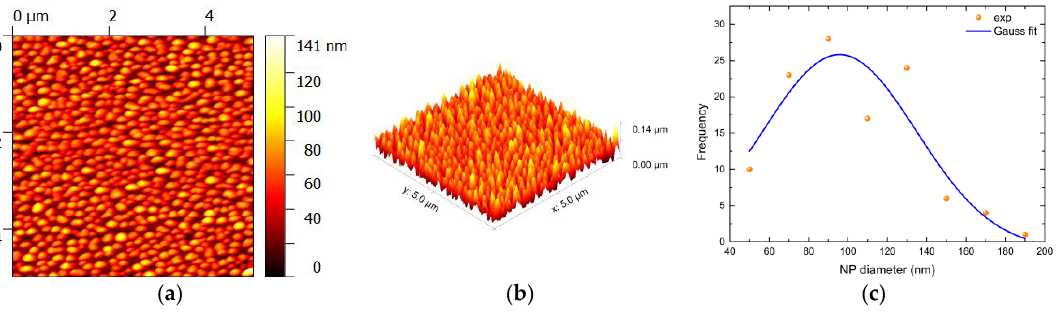
Figure 12. ( a ) Two- and ( b ) three-dimensional AFM images and nanoparticle size distribution diagram ( c ) for the area of the Ag #4 (6 nm) film irradiated at a frequency of 80 kHz.